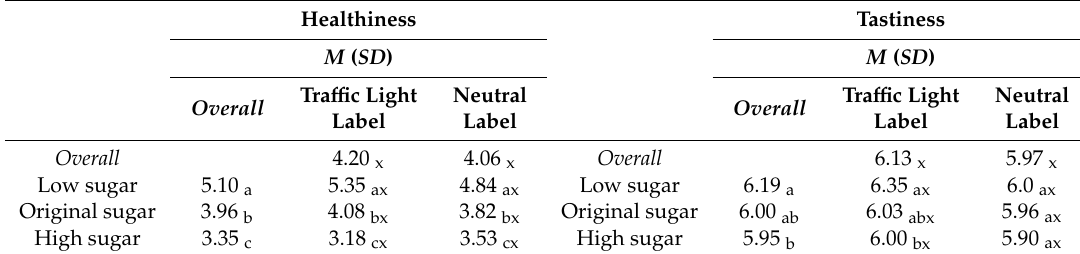
Table 6. Estimated marginal means of healthiness and tastiness ratings for products with low, original, and high sugar level in the tra ffi c light label and neutral label condition.